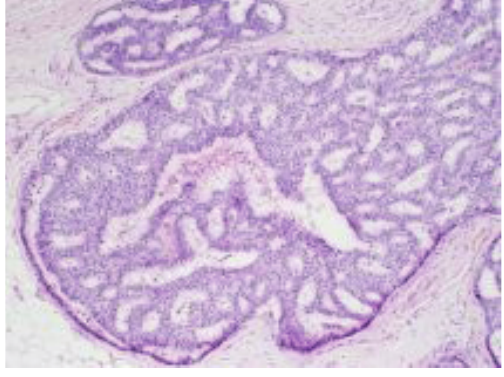
Figure 3: Low-grade DCIS. Figure 4: High-grade